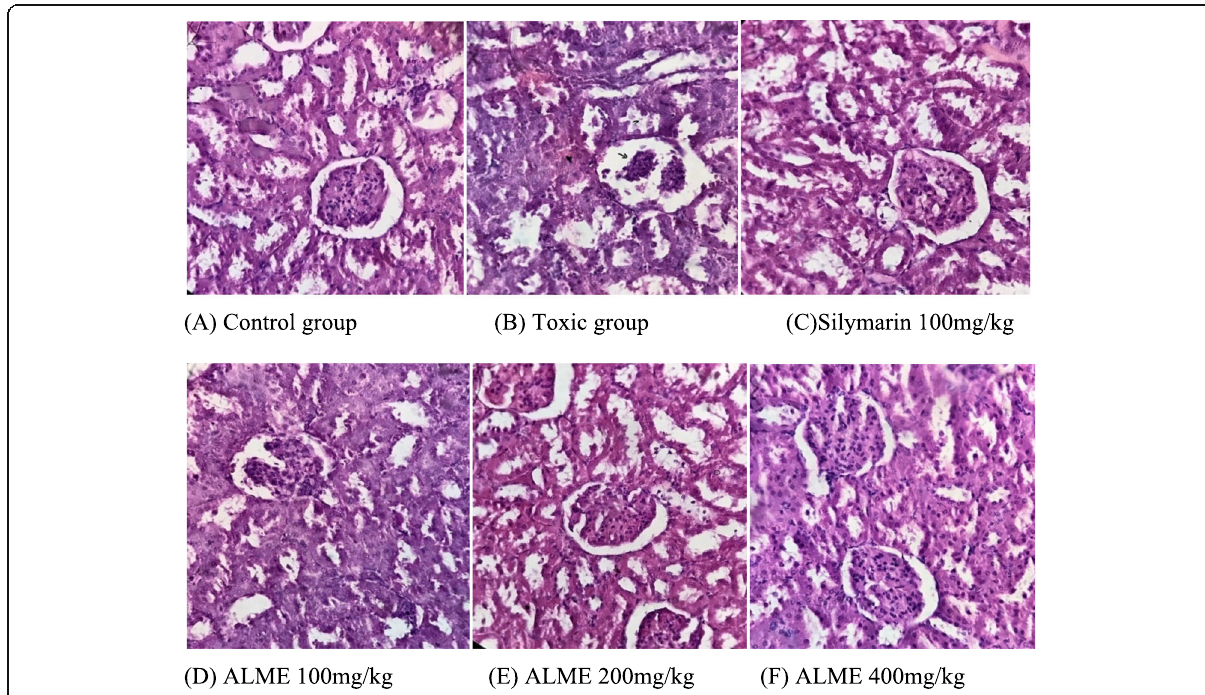
Fig. 2 Histopathological changes in renal tissue of rats. Done by Digital Motic Microscope Magnification 100X. a A control kidney with normal architecture. b Rats treated with cadmium alone, with congested shrunk and completely degenerated glomeruli, debris in the lumen of some renal tubules and degeneration of renal tubules. c And e Rats treated with Standard and ALME 200 mg/kg, along with cadmium exhibited normal architecture. d Rats treated with ALME 100 mg/kg and cadmium showed mild degeneration of glomerulus. f Rats treated with ALME 400 mg/kg and cadmium maintained normal renal corpuscle and renal tubule more or less like normal